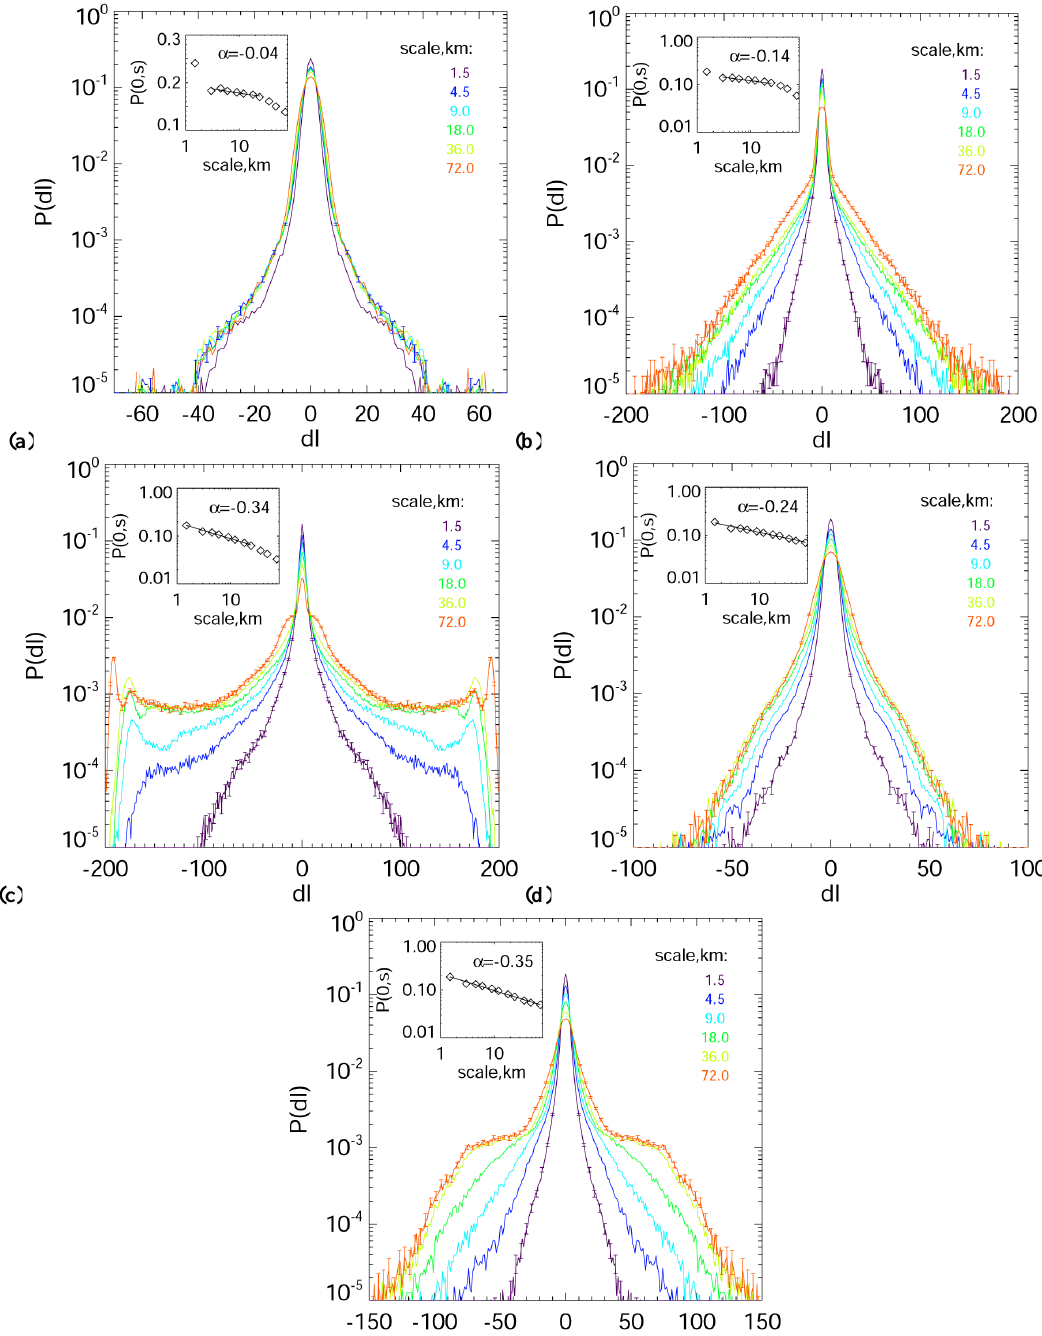
Fig. 3. Dependence of PDF of intensity fluctuations on spatial scale for several 20s intervals starting from: (a) 22:10:00; (b) 22:26:20; (c) 22:55:20; (d) 23:54:20; (e) 00:10:00. Insets: symbols – maximum values of the PDF, line – the least sqaures power-law approximation as P(0, s) ∝ s α . Uncertainty in the α values is less than